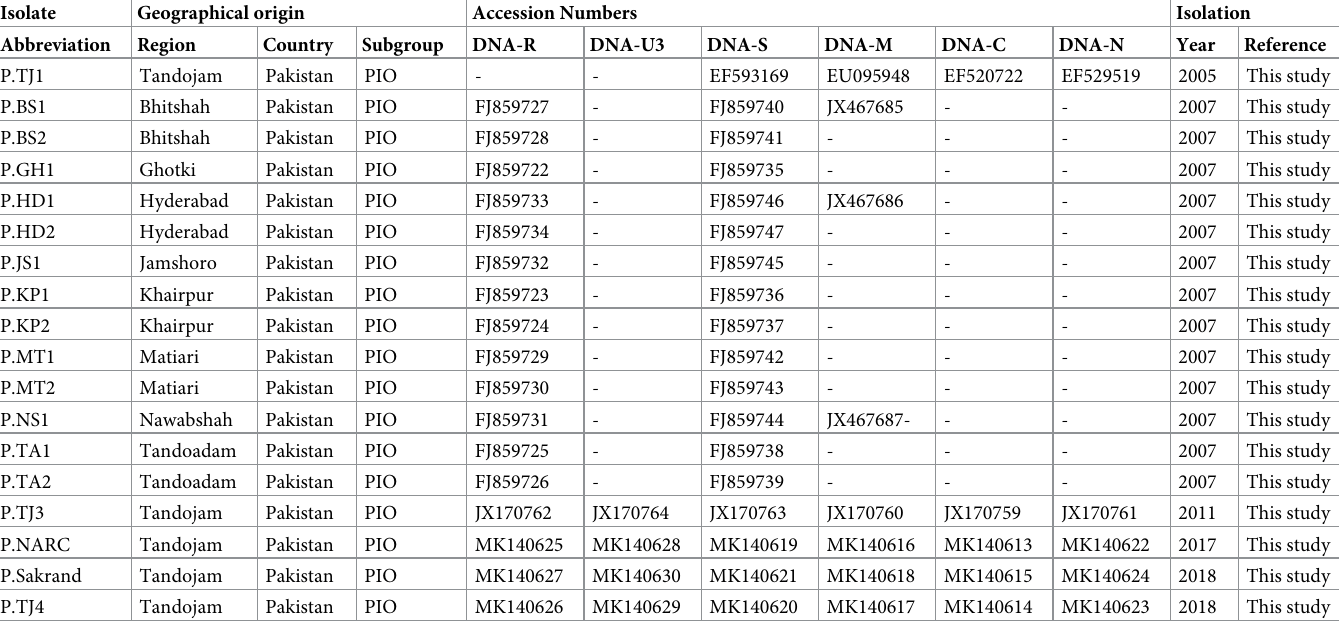
Table 2. Description of Banana bunchy top virus isolates sequenced from Pakistan for this